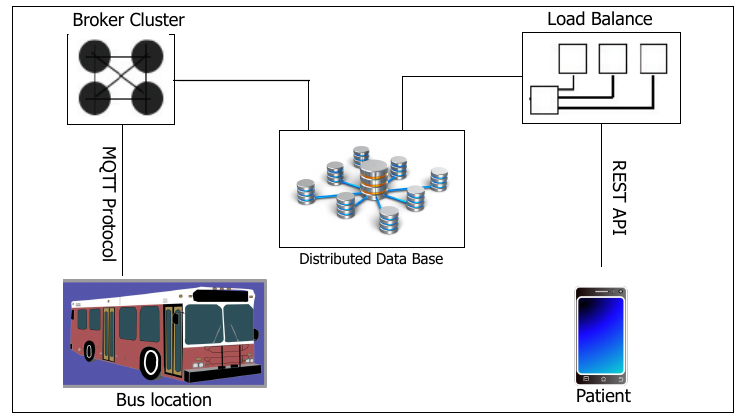
Figure 6. System architecture.